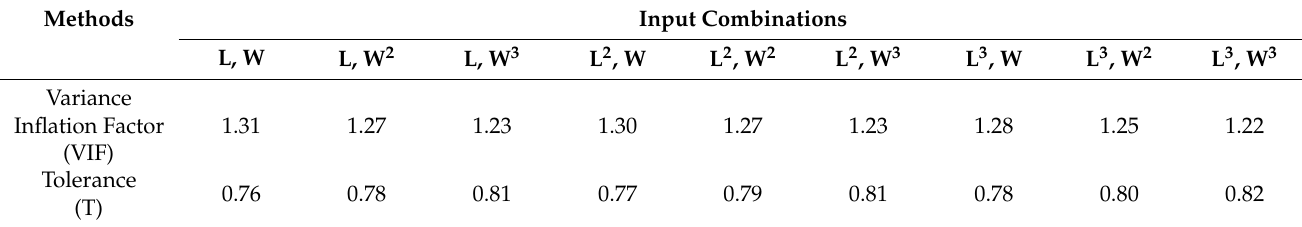
Table 5. The values of VIF and T of L, W, and their input